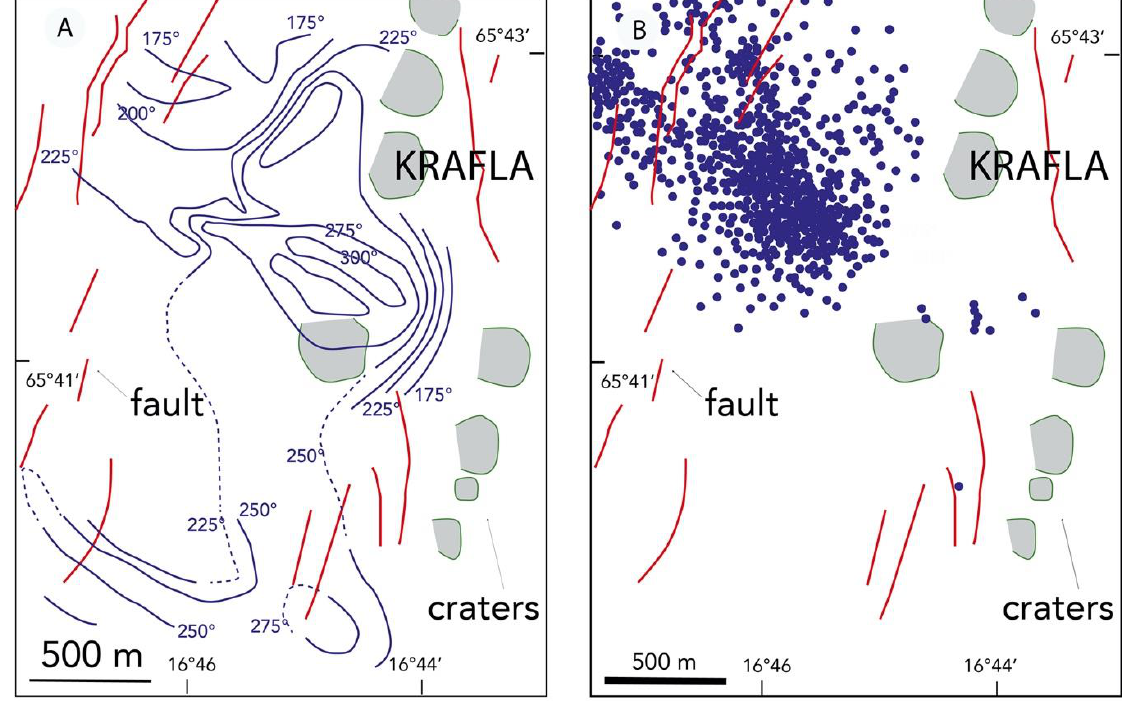
Figure 19. ( a ) Isotherms showing the distribution of temperature at Krafla; ( b ) distribution of epicenters in the geothermal area of Krafla. Their depth is between 1.8 and 2.4 km. After Reference